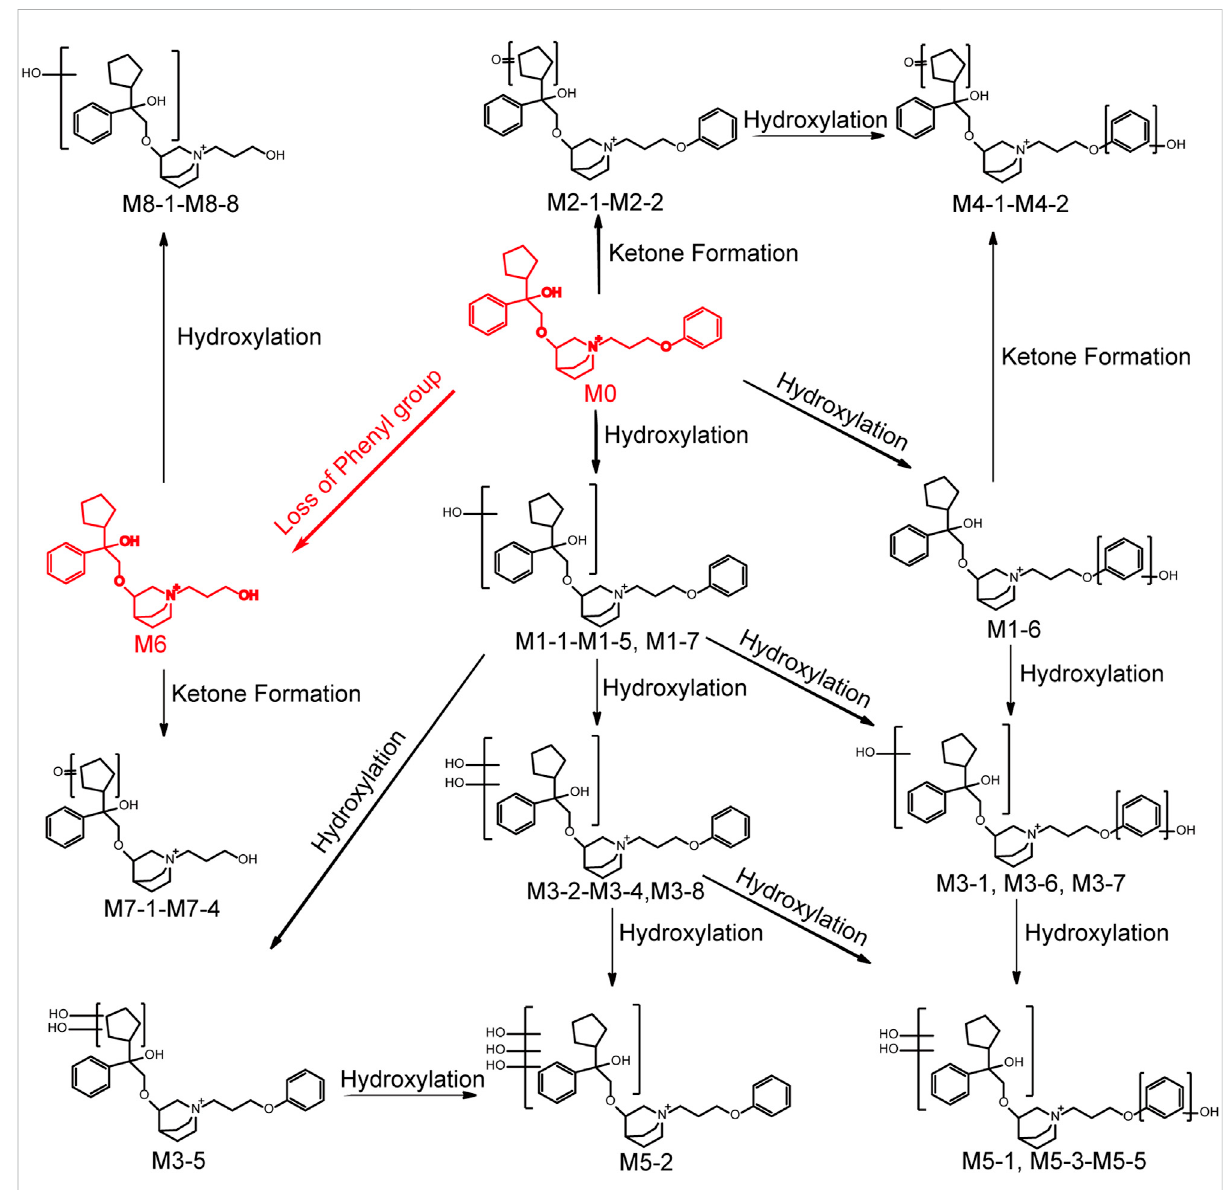
FIGURE 4 Chemical structures of the metabolites and proposed metabolic pathways of 101BHG-D01 in human liver